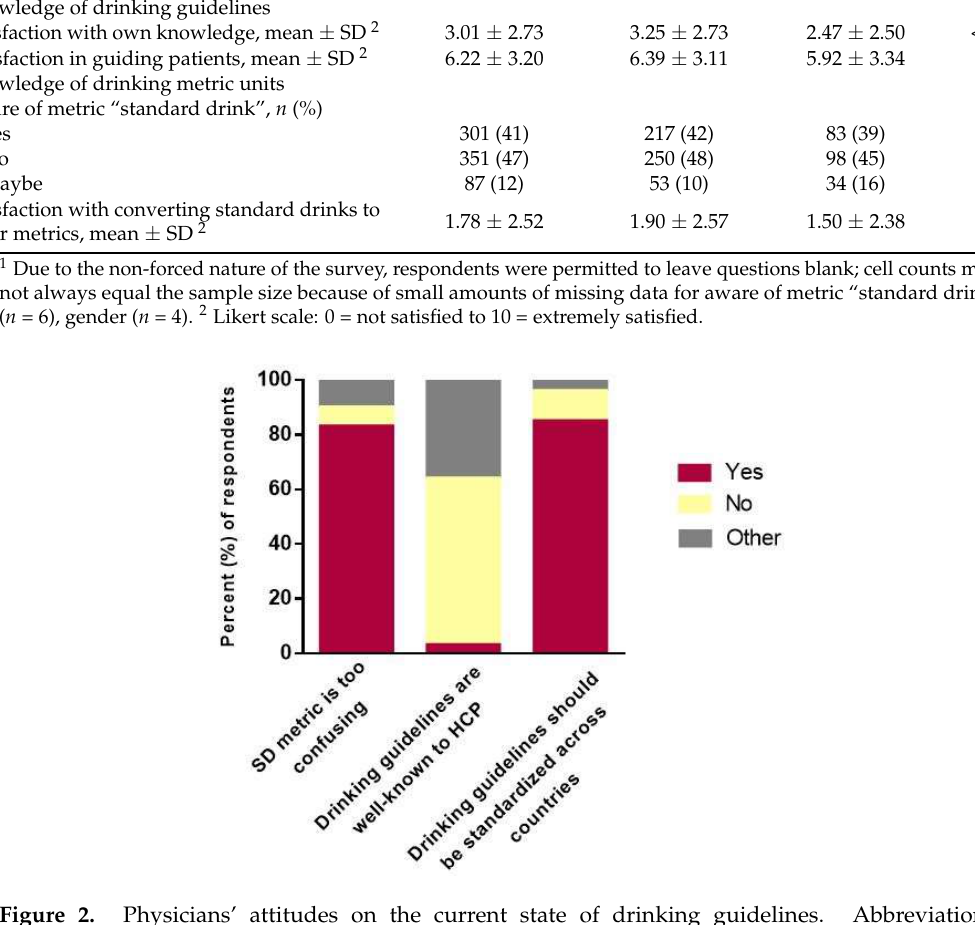
Figure 2. Physicians’ attitudes on the current state of drinking guidelines. Abbreviations: HCP = healthcare providers; SD = standard drink.